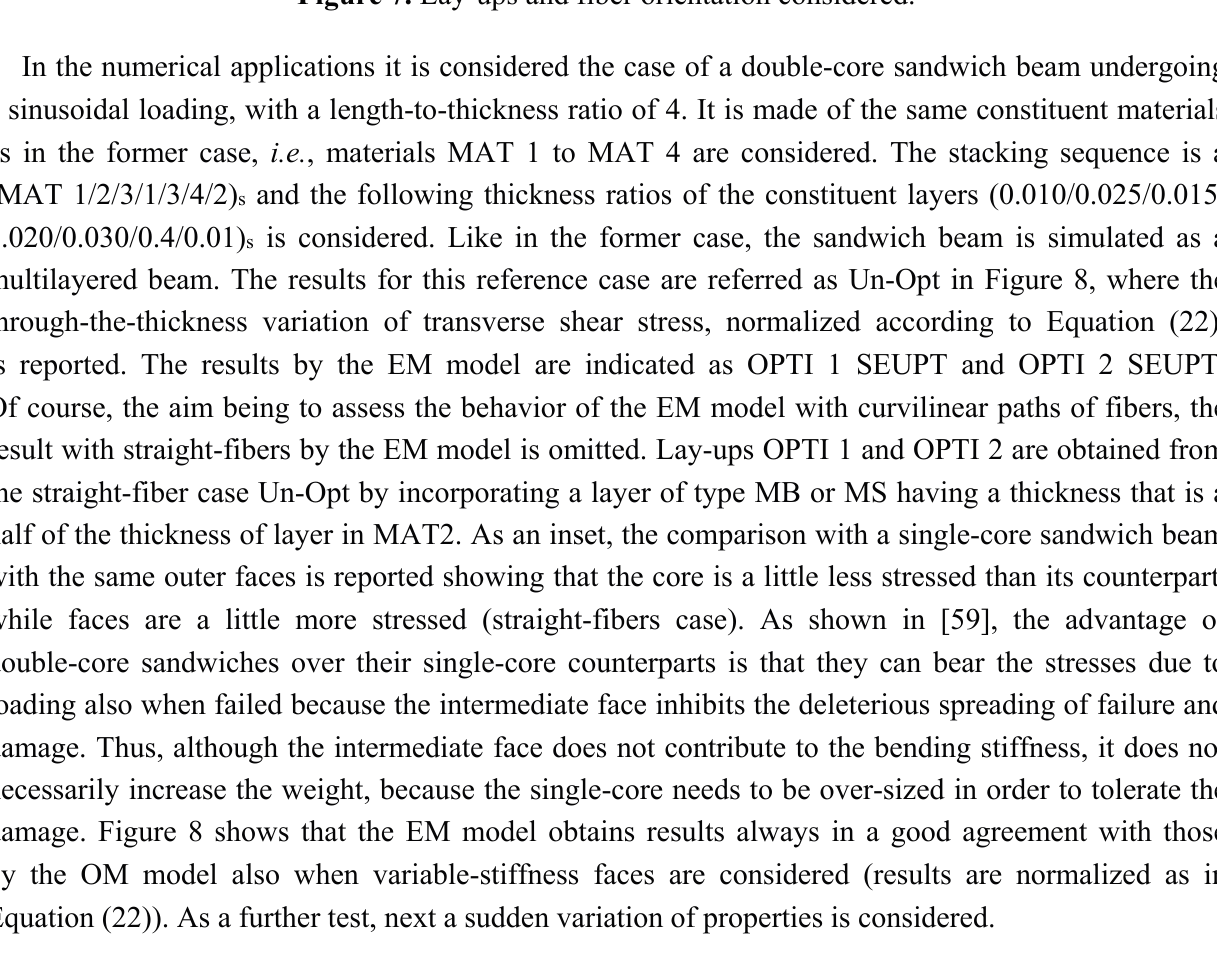
Figure 7. Lay-ups and fiber orientation